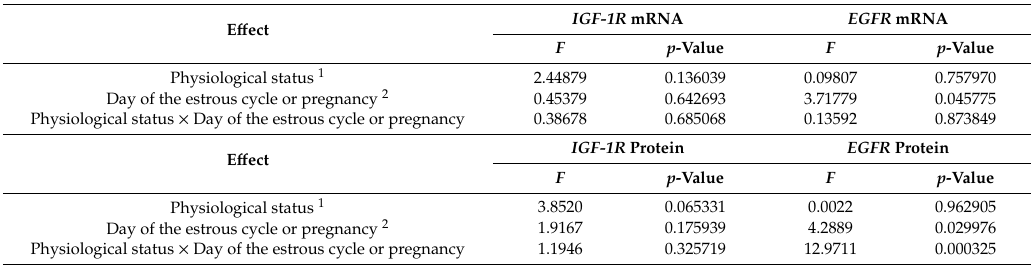
Table 2. Insulin-like Growth Factor 1 Receptor ( IGF-IR ) and Epidermal Growth Factor Receptor ( EGFR ) mRNAs expression and EGFR and IGF-IR protein abundance—the main e ff ects and the interactions observed among factors (multiway ANOVA). E ff